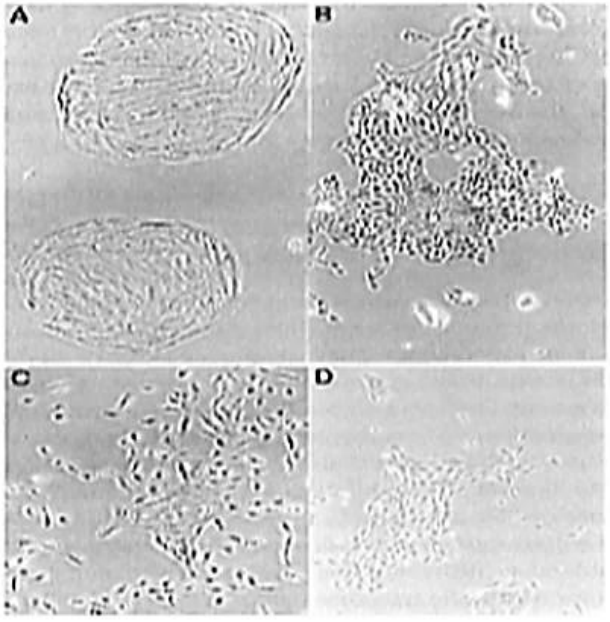
Figure 10. These four panels illustrate the induction of differentiation of Type I (human adult breast stem cells) to Type II (differentiated human breast epithelial cells, HBEC) by genistein and vitamin D3. The cells were treated with ( A ) ethanol (0.3%. v/v ), solvent control; ( B ) cholera toxin (i ng/mL), positive control; ( C ) genistein (10.7 M); and ( D ) vitamin D, (10.9 M). Photos were taken 12 days after treatment. From Hsieh and Chang, [84]; Permission granted from Chinese Pharm, J. (Taiwan).